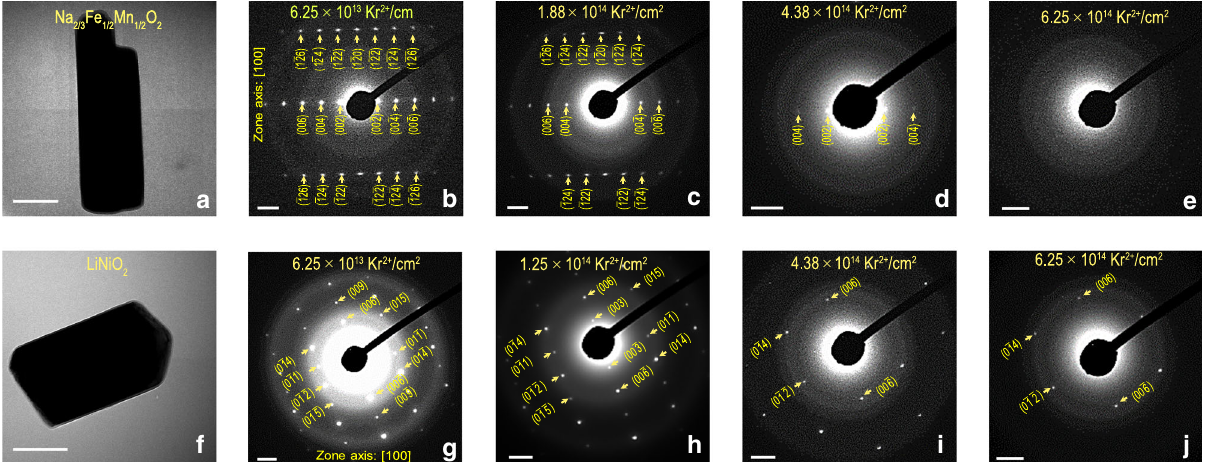
Fig. 2 In situ structural evolution of layered cathodes under Kr ion irradiation. a The Na 2/3 Fe 1/2 Mn 1/2 O 2 particle that is irradiated at room temperature. The scale bar corresponds to a length of 100nm. Electron diffraction of Na 2/3 Fe 1/2 Mn 1/2 O 2 at the fl uence of b 6.25×10 13 Kr 2 + /cm 2 , c 1.88× 10 14 Kr 2 + /cm 2 , d 4.38× 10 14 Kr 2 + /cm 2 , and e 6.25×10 14 Kr 2 + /cm 2 . The scale bars in b – e are equivalent to 2 1/nm. f The LiNiO 2 particle that is irradiated at room temperature. The scale bar corresponds to a length of 100nm. Electron diffraction of LiNiO 2 at the fl uence of g 6.25× 10 13 Kr 2 + /cm 2 , h 1.25×10 14 Kr 2 + /cm 2 , i 4.38×10 14 Kr 2 + /cm 2 , and j 6.25×10 14 Kr 2 + /cm 2 . The scale bars in g – j are equivalent to 2 (cid:1) (peak damage) is produced within the depth of ~300 nm of both space group R 3 m when viewed from the [100] zone axis (Fig. 2g), Na 2/3 Fe 1/2 Mn 1/2 O 2 and LiNiO 2 (Supplementary Fig. 2b, d). in corroboration with the global XRD pattern of the material. The Structural evolution is monitored in situ by electron diffraction brightness of the diffraction spots can be a measure of the (ED) with increasing fl uence of Kr ion irradiation at room crystallinity of the materials. For irradiated Na 2/3 Fe 1/2 Mn 1/2 O 2 and temperature (Fig. 2). The ED of Na 2/3 Fe 1/2 Mn 1/2 O 2 can be indexed LiNiO 2 , the spots get dimmer with increasing fl uence of Kr ion as lattice planes from a hexagonal lattice with P 6 3 / mmc space irradiation. We measured the brightness of the spots in terms of group when viewed from the [100] zone axis (Fig. 2b), in pixel values of a grayscale image (black being 0 and white being corroboration with the global crystal structure deciphered from the 255 in pixel value). Starting with a range of pixel values from XRD pattern. The diffraction spots from the particle of LiNiO 2 can 200 to 255 within the spot, the spots for the lattice plane (004) of be indexed as lattice planes from the rhombohedral lattice with the Na 2/3 Fe 1/2 Mn 1/2 O 2 and (006) plane of LiNiO 2 contain increasingly